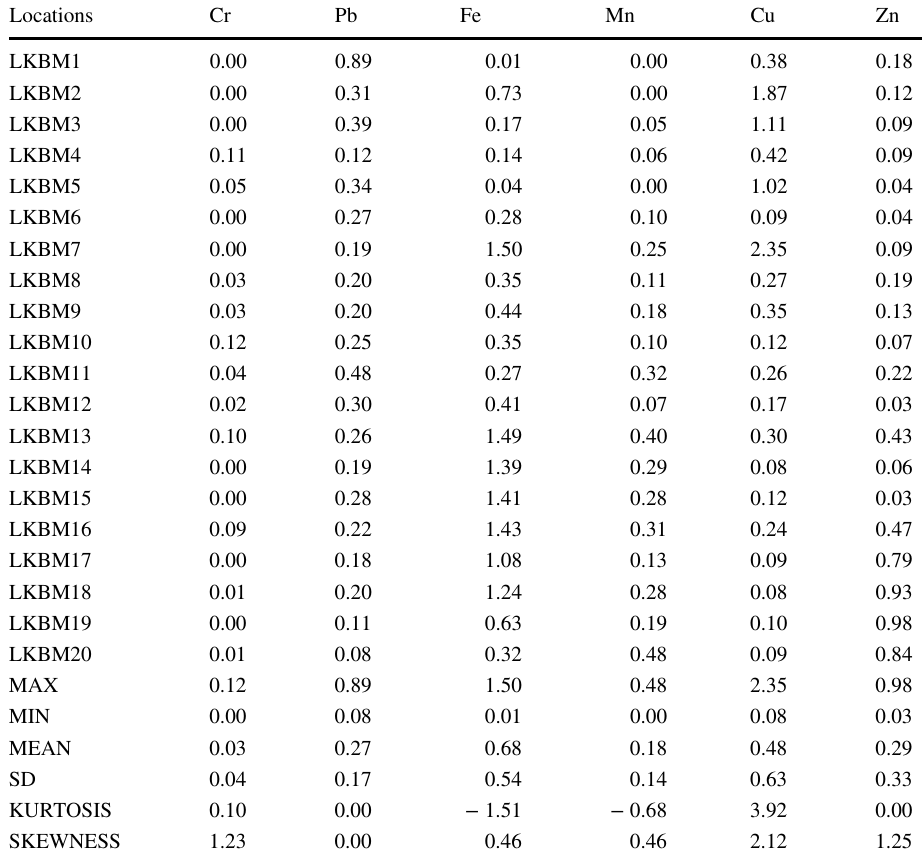
Table 6 Descriptive statistics of heavy metals in post-monsoon season at North Guwahati